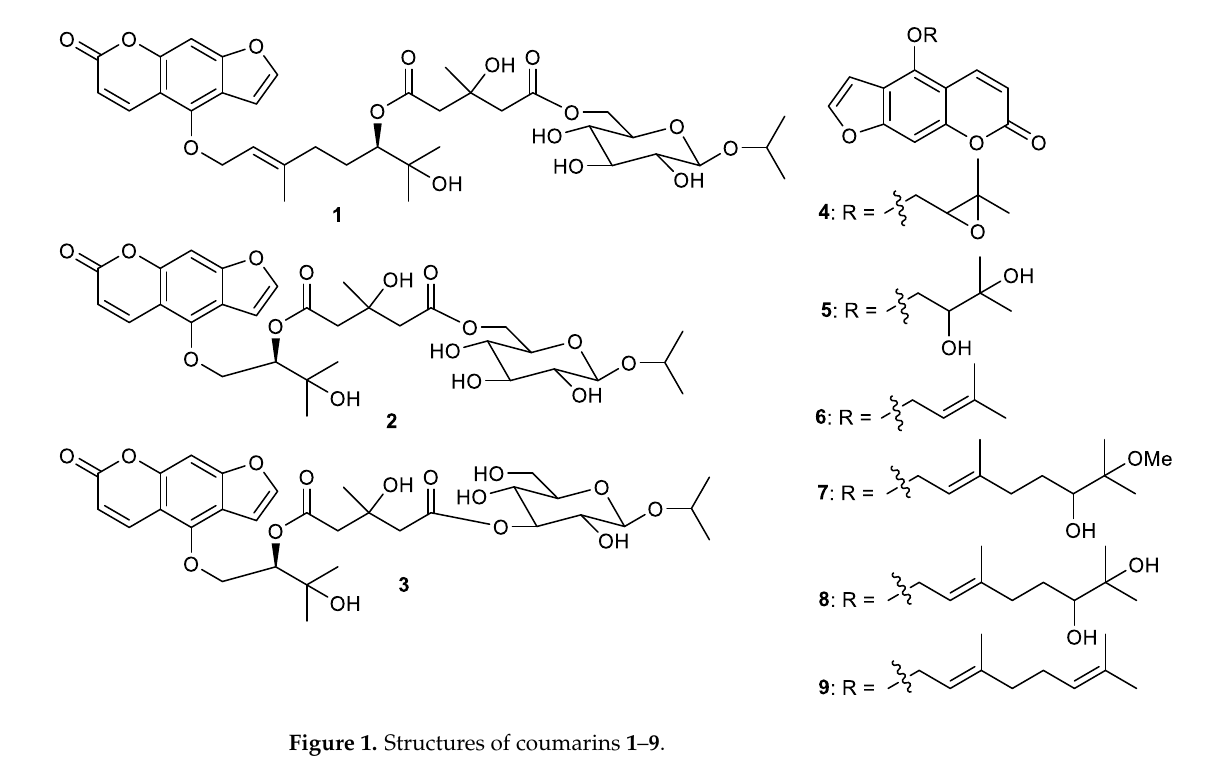
Figure 1. Structures of coumarins 1 – 9 .